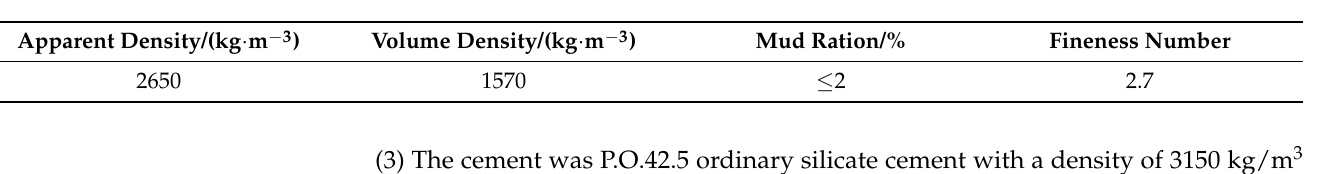
Table 2. Physical properties of sand.